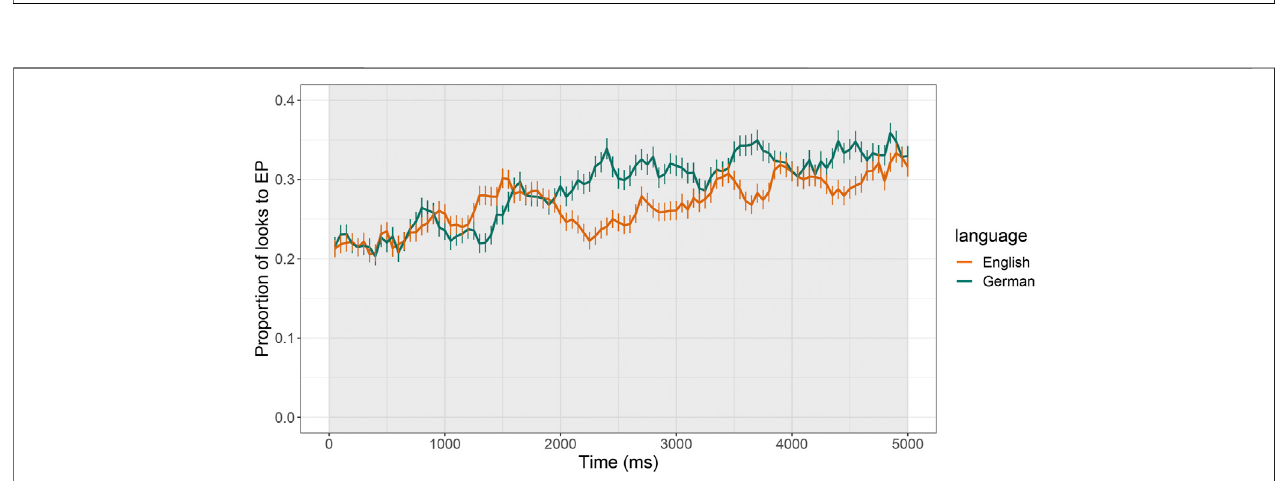
FIGURE4| Proportionoflooks( fi xations)totheEPinPhase3(onlyEPvisible,collapsedforlongandshorttrials)byLanguage,withtheanalysistime-windowof5s highlighted in grey.